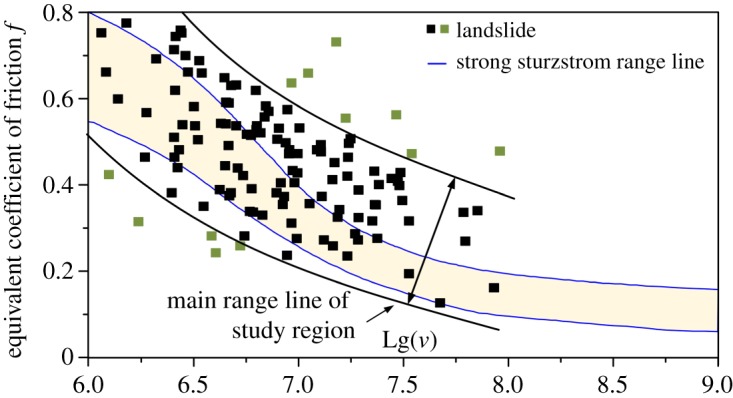
Movement characteristics of the landslides. Lg(v) = Log10(v), where v is landslide volume (m3).